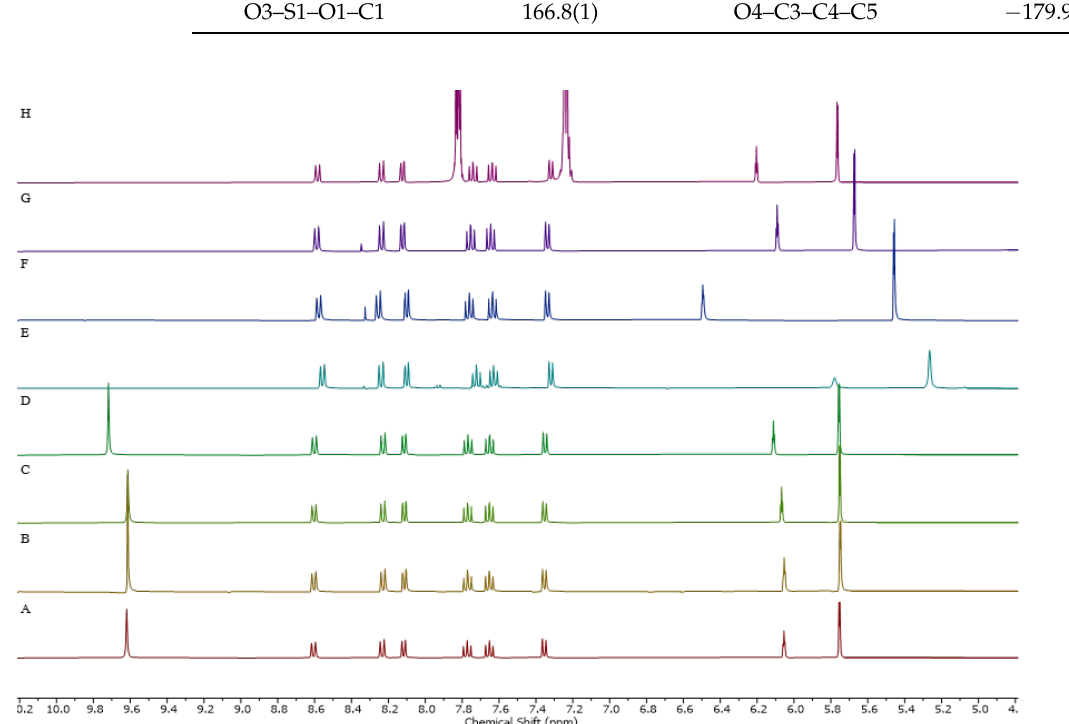
Figure 4. 1 H-NMR spectrum of sensor R1 (1 × 10 −2 M) ( A ) with 6 equivalents of different anions Br − ( B ), I − ( C ), Cl − ( D ), F − ( E ), H 2 PO 4 − ( F ), CH 3 COO − ( G ), and C 6 H 5 COO − ( H ) in d 6 -DMSO.